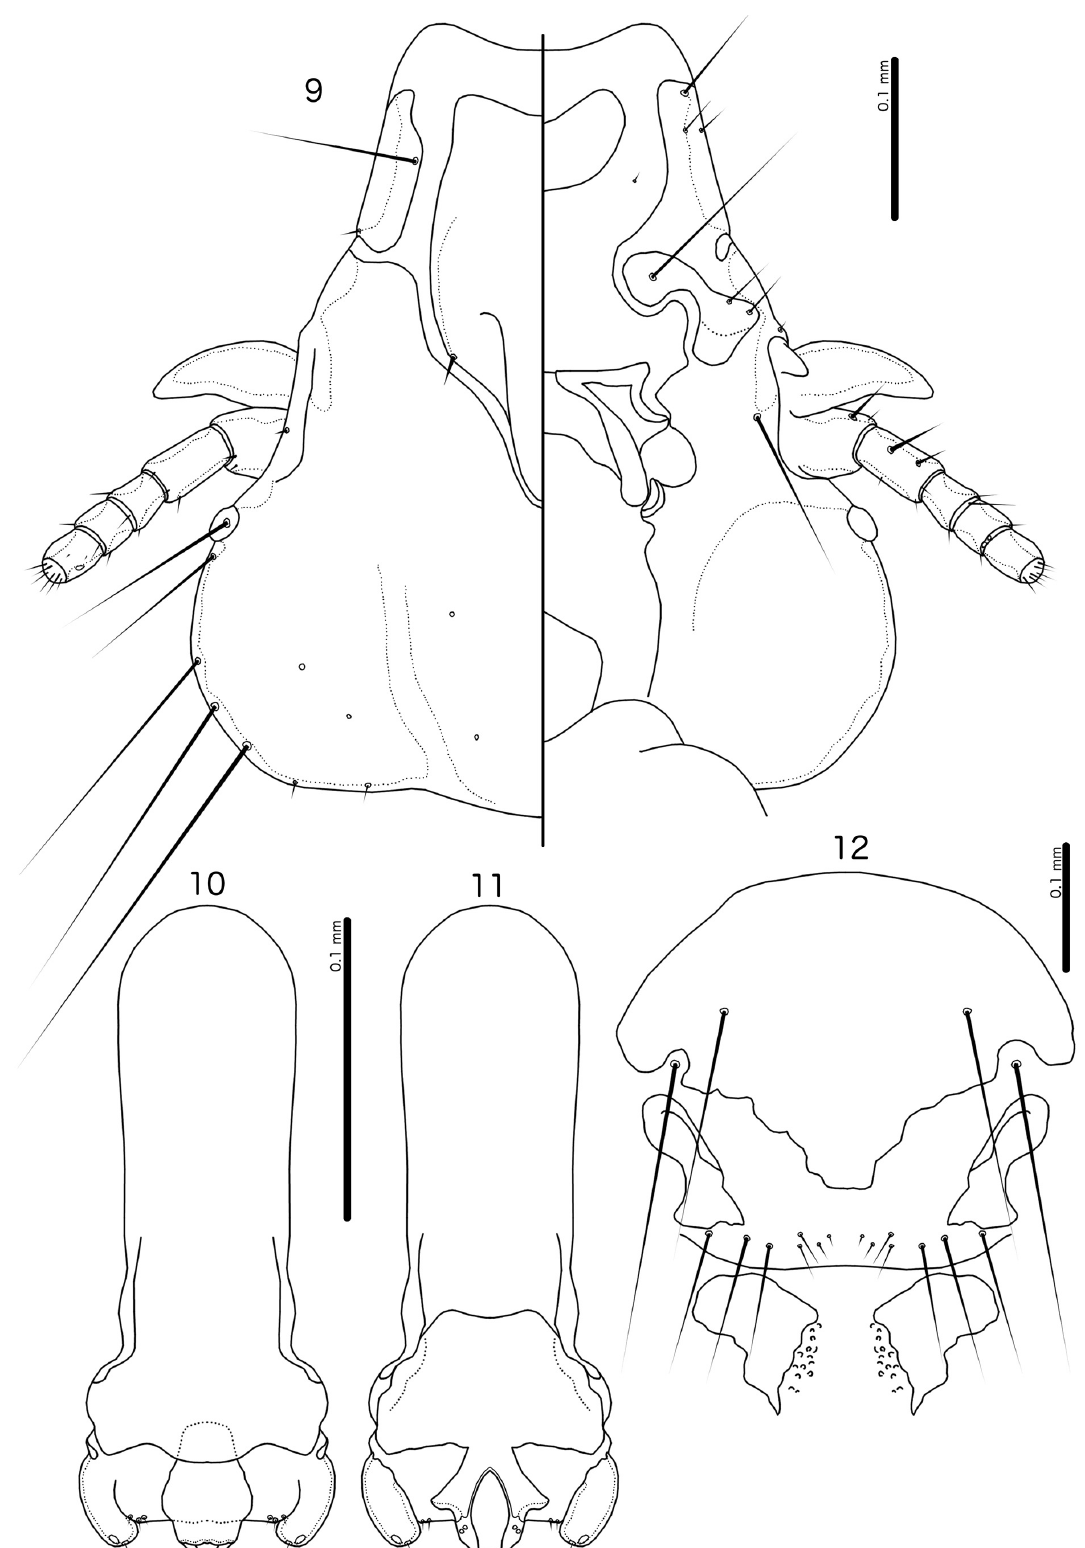
Figs 9–12. Philopterus micropunctatus sp. nov. ex Anthus hodgsoni Richmond, 1907. 9 . Male head, dorsal and ventral views. 10 . Male genitalia, dorsal view. 11 . Male genitalia, ventral view. 12 . Female subgenital plate, vulval margin, and subvulval plates, ventral